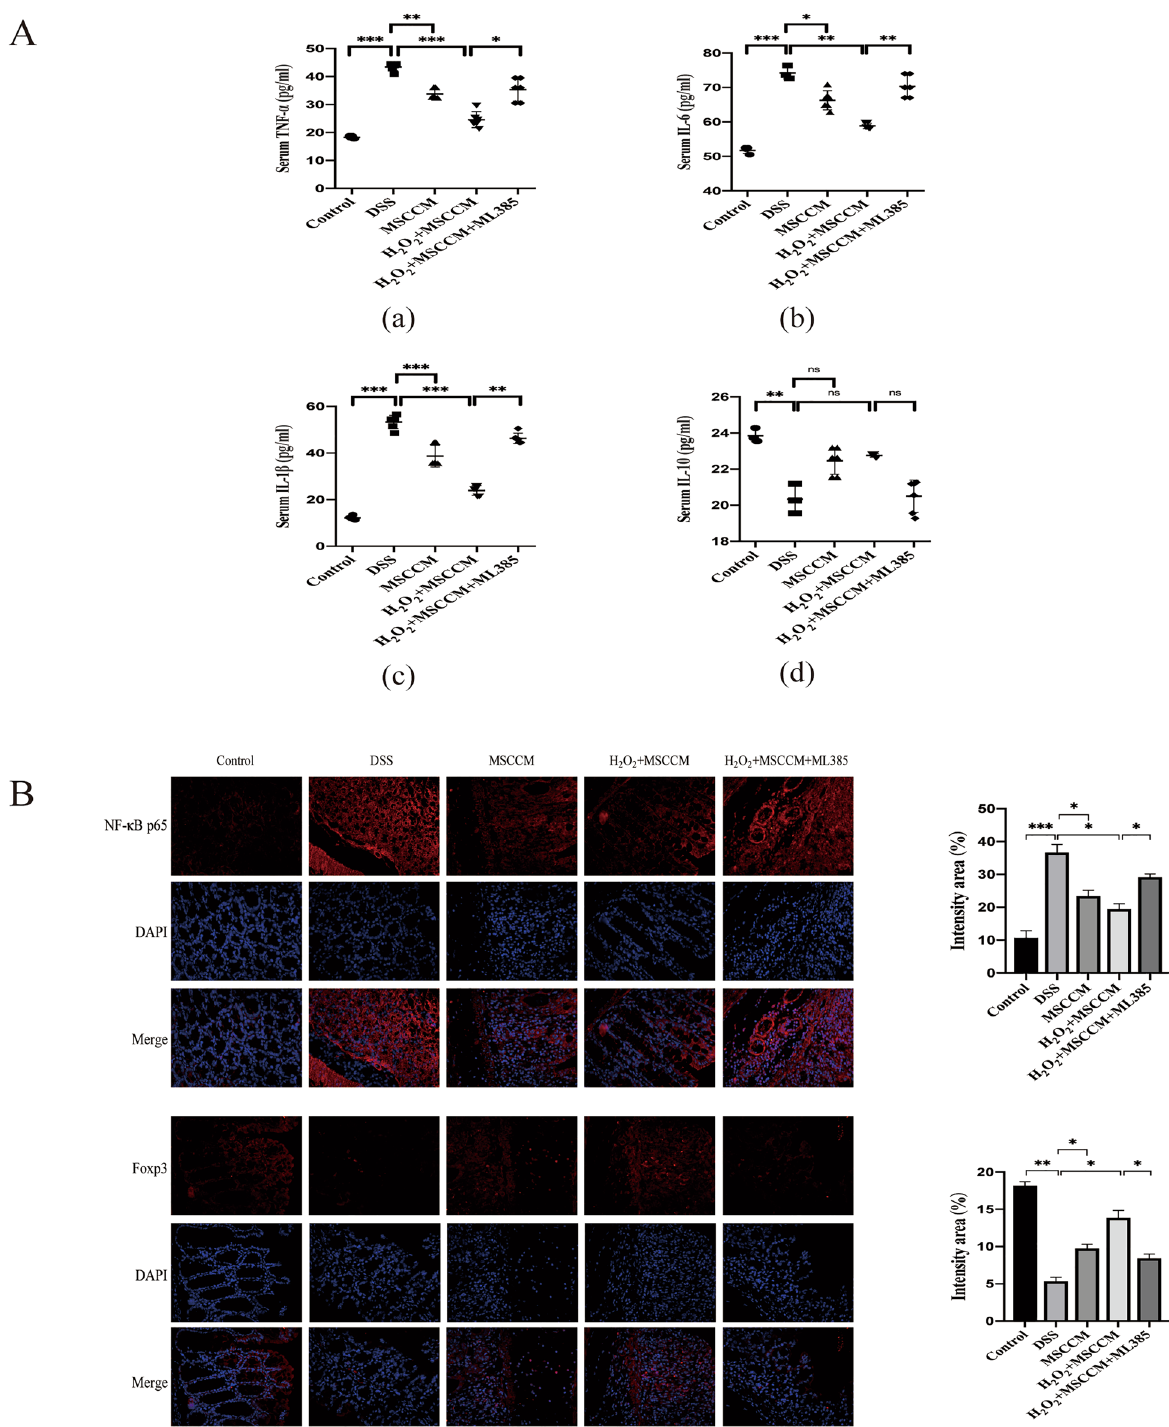
Figure 5. H 2 O 2 pretreated MSC-CM regulates the inflammatory cytokines in colon tissue. ( A ) The levels of inflammatory cytokines including TNF-α (a), IL-6 (b), IL-1β (c), and IL10 (d) in colon tissue homogenate were detected by ELISA. Data are expressed as the mean ± SD. n = 6 animals per group per time point. * P < 0.05, ** P < 0.01, and *** P < 0.001; ns no significance. ( B ) Sections of colonic tissues were immunostained for revealing NF-κB p65 proteins (red) and Foxp3 proteins (red) as indicated. The slides were counterstained with DAPI (blue), and the images were captured using an inverted fluorescence microscope. Magnification: ×